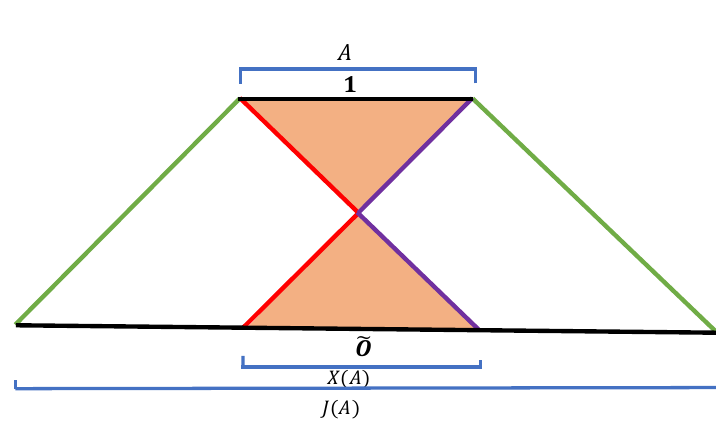
Figure 15 . From causality the operators in the past domain dependence of A and future domain dependence of X ( A ) are fixed by operators in A and X ( A ) respectively. From the two “Cauchy surfaces”, shown in red and purple, which bound the regions of determined operators, by repeatedly using items (3) and (4) one can uniquely determine the all other operators in the portion of the circuits between the green lines, including the remaining parts of the initial operator in J ( A ) .